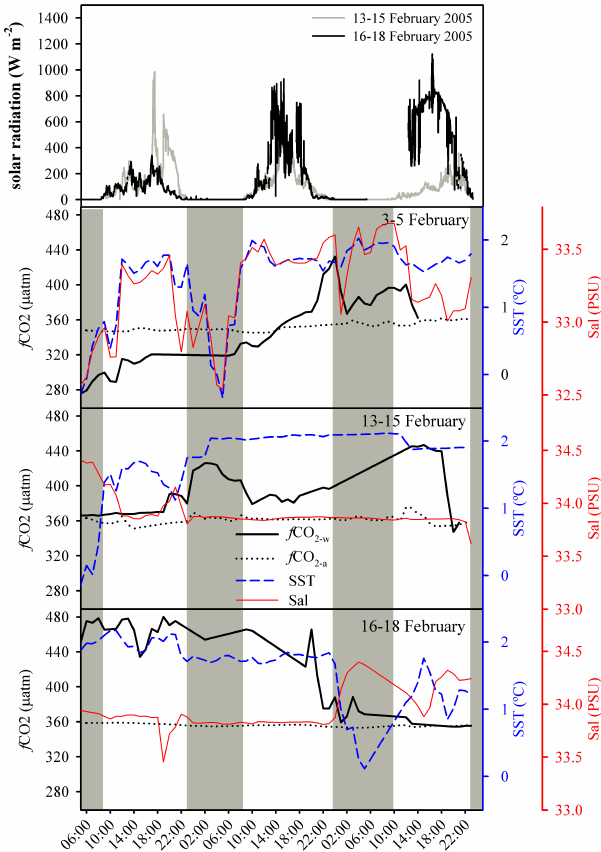
Figure 11. Diel variability of f CO 2 − a , f CO 2 − w , SST and salinity. The top panel shows solar radiation for the different days sampled; data for the 3–5 February cycle are missing due to equipment fail-